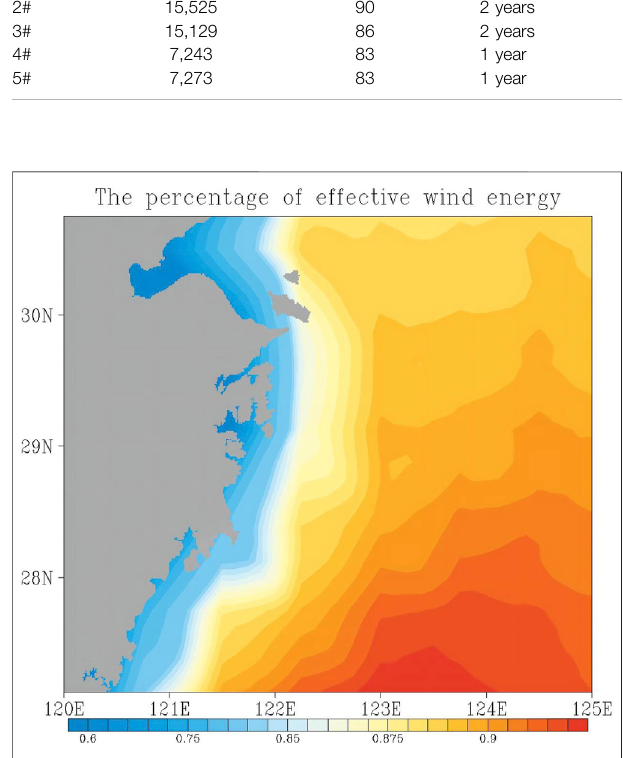
FIGURE 3 | The percentage of effective wind energy of the Zhejiang coastal area (units:w · m − 2